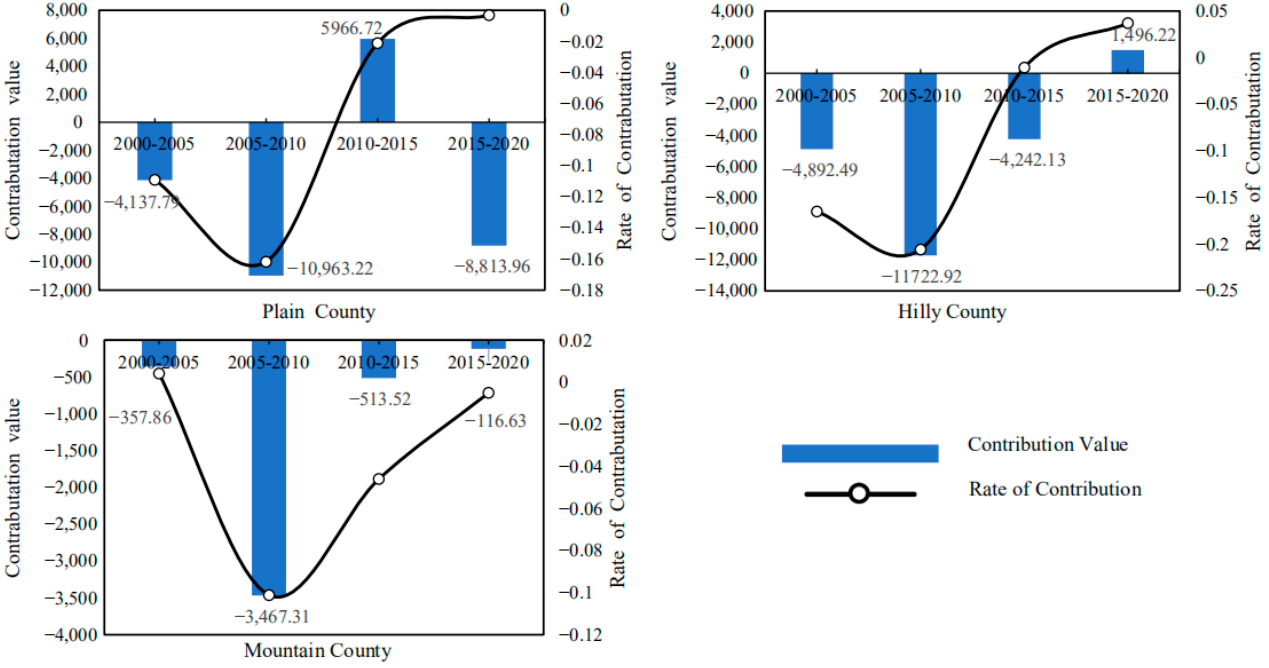
Figure 13. Topographic heterogeneity of agricultural output level increase and emission effect (including Plain County, Hilly County, Mountain County).